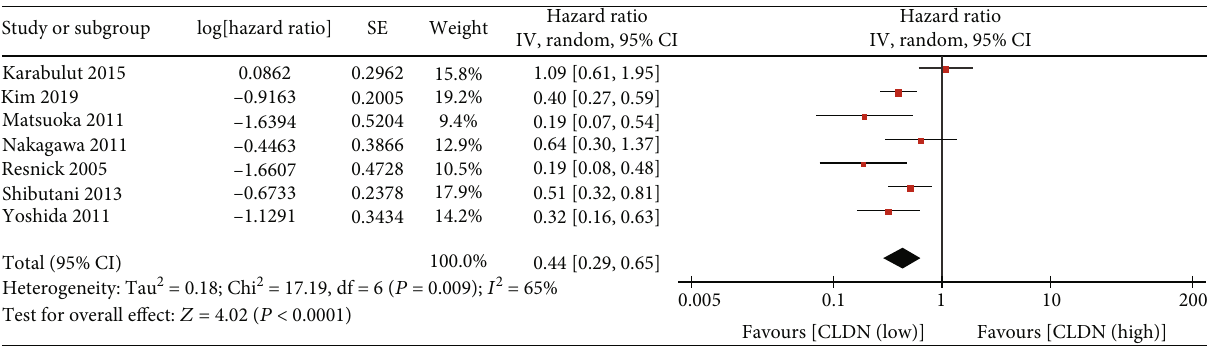
Table 2: Meta-analysis of the correlation between claudin-1 expression and clinicopathological factors of colorectal cancer. Clinicopathological parameter No. of studies Participants RR (95% CI) Analysis model